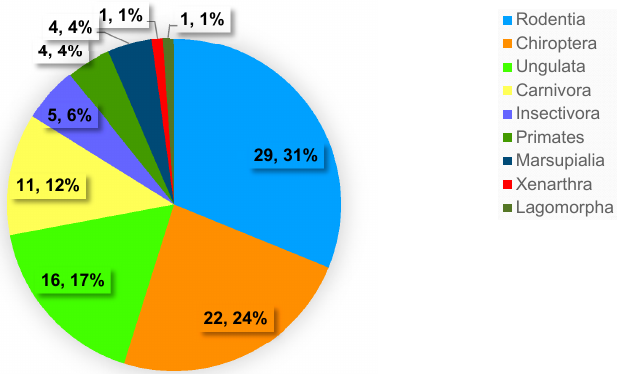
Figure 4. Mammals—hosts of Demodecidae (species number and % of mammals from different orders).